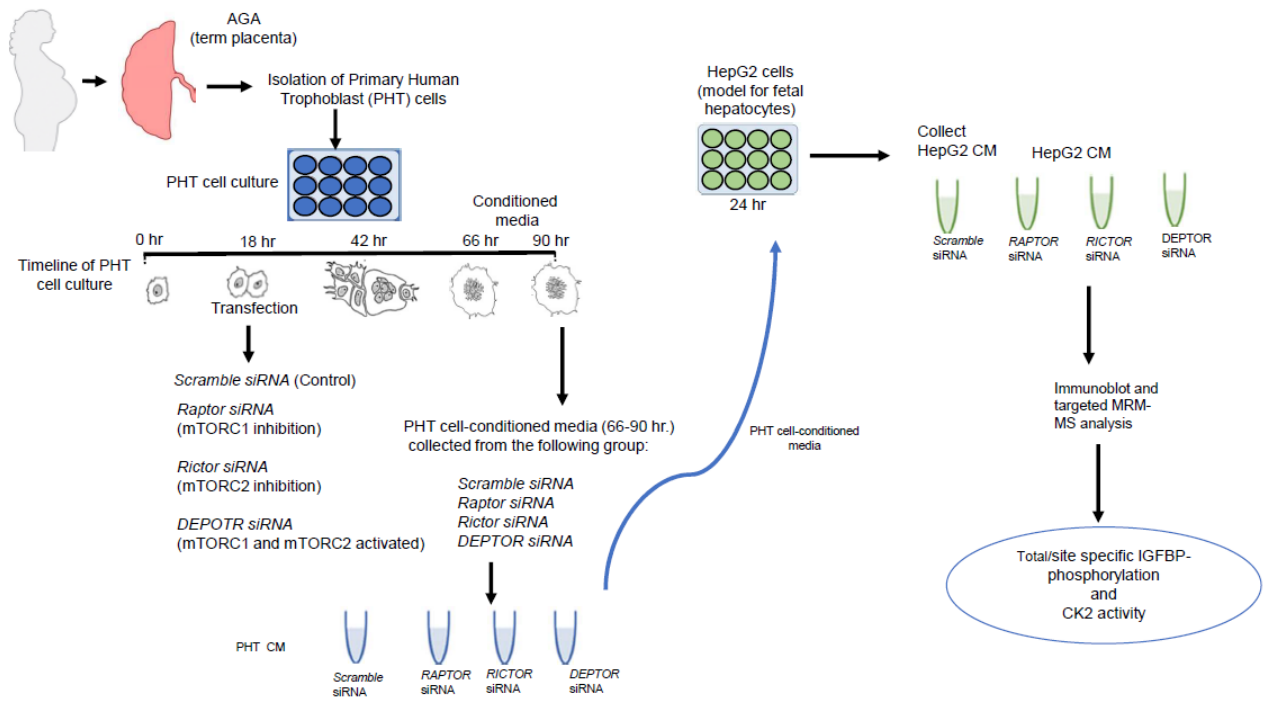
Figure 1. Schematic representation of the experimental design.